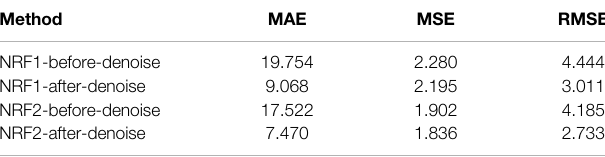
TABLE 1 | Comparison of predictive results of saturation before and after denoising using wavelet transforms.